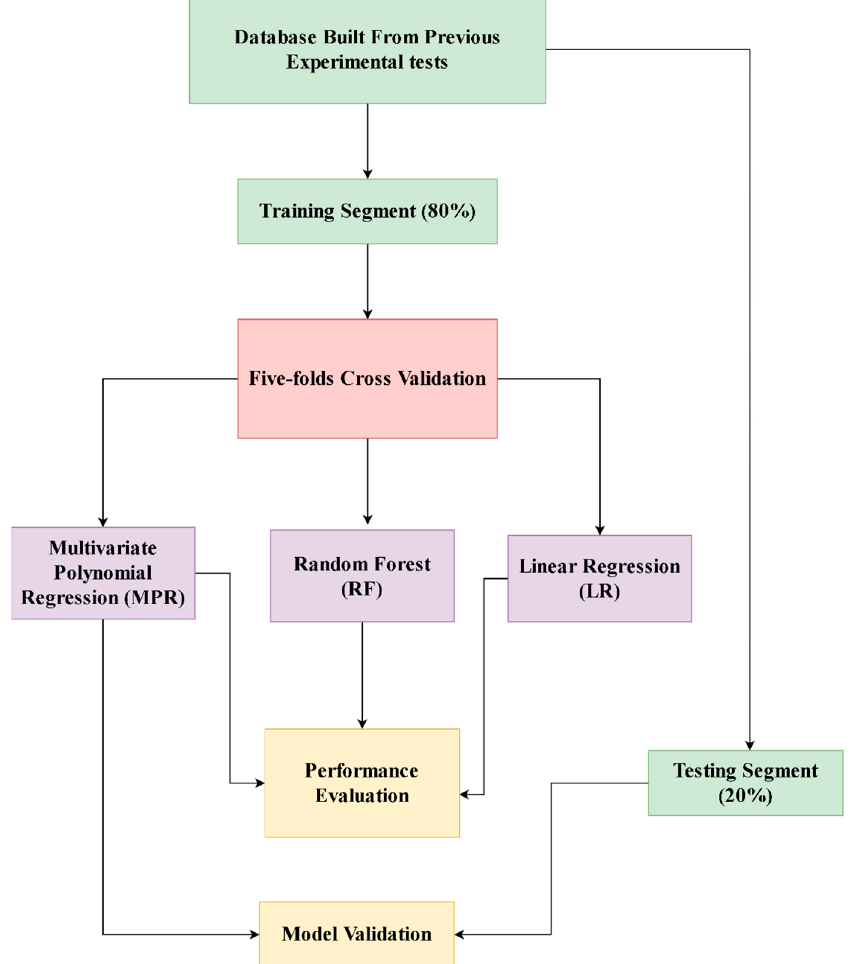
Figure 1. Research methodology.